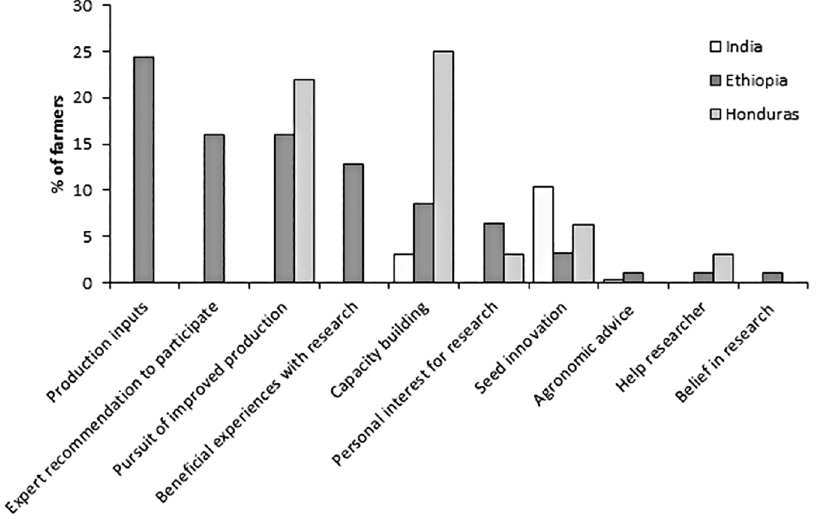
Fig 6. Additional motivations to participate in crop improvement trials using the crowdsourcing approach.